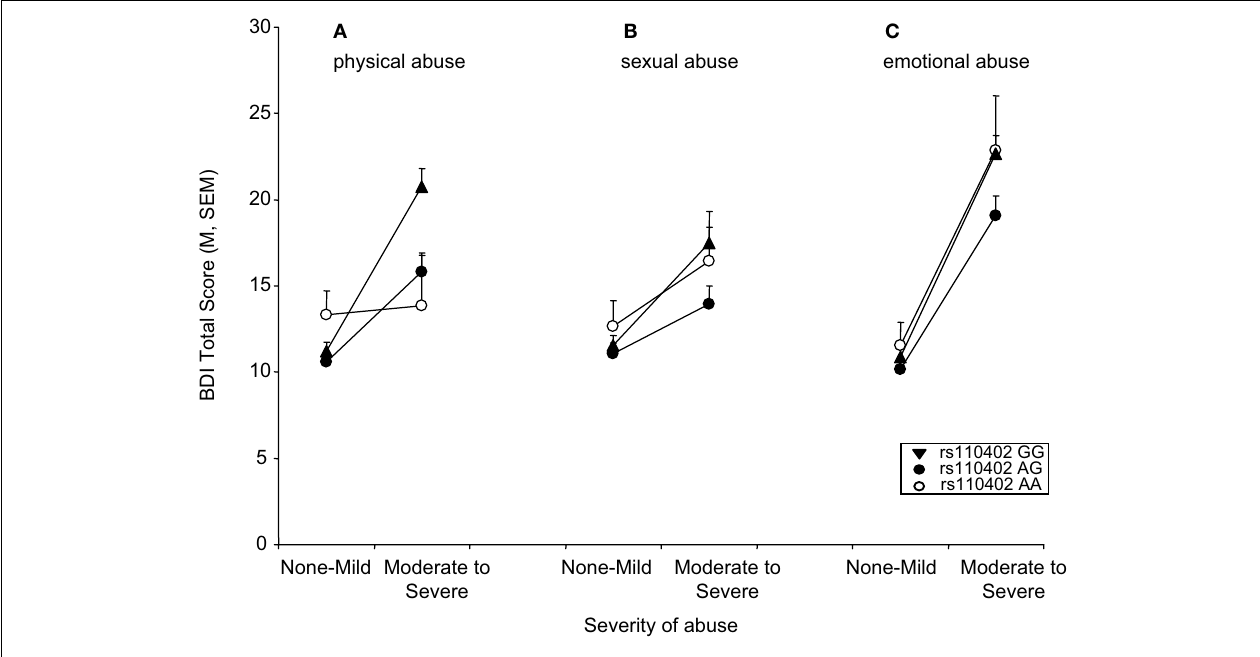
FIGURE 2 | Interaction of CRHR1 rs110402 genotype and subtype of genotype distribution was as follows: AA = 57, AG = 364, GG = 366 for the childhood abuse exposure on current depressive symptoms ( N = 1058). none-mild childhood abuse exposure group and AA = 15, AG = 111, (A) There was a signifi cant interaction of moderate to severe physical abuse GG = 145 for the moderate-severe childhood abuse exposure group. (C) with rs110402 genotype ( F = 5.45, p = 0.004). The genotype distribution There was no signifi cant interaction of moderate to severe emotional abuse 2,1058 was as follows: AA = 58, AG = 372, GG = 402 for the none-mild childhood with rs110402 genotype. The genotype distribution was as follows: AA = 60, abuse exposure group and AA = 14, AG = 103, GG = 110 for the moderate- AG = 390, GG = 409 for the none-mild childhood abuse exposure group and severe childhood abuse exposure group. (B) There was no signifi cant AA = 12, AG = 85, GG = 103 for the moderate-severe childhood abuse interaction of moderate to severe sexual abuse with rs110402 genotype. The exposure group.